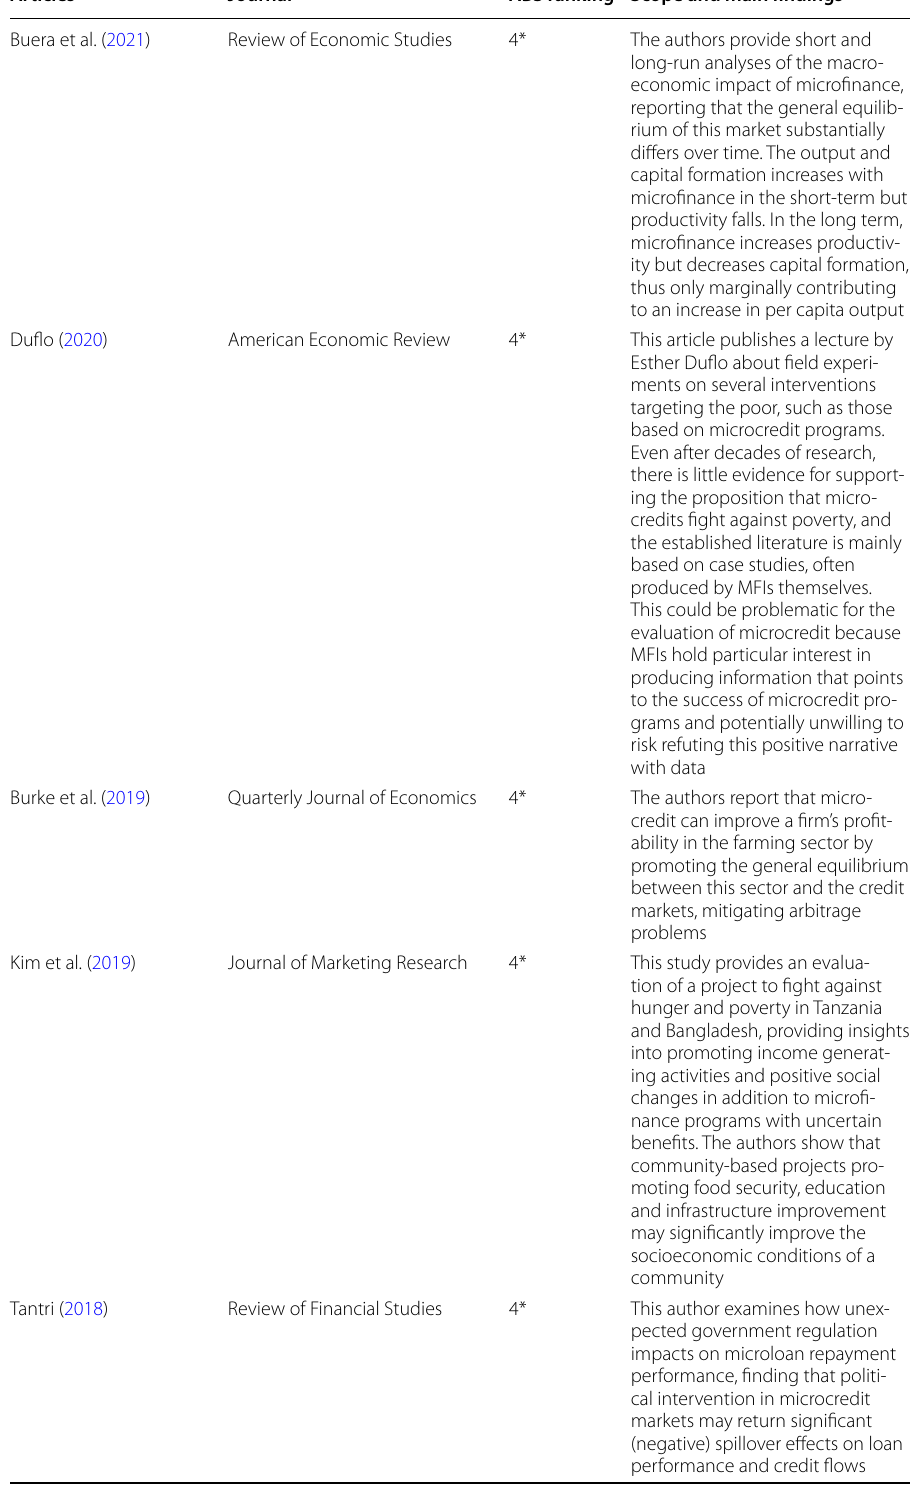
Table 10 All published articles in ABS (4, 4*) ranked journals: 2018–03:2021 Articles